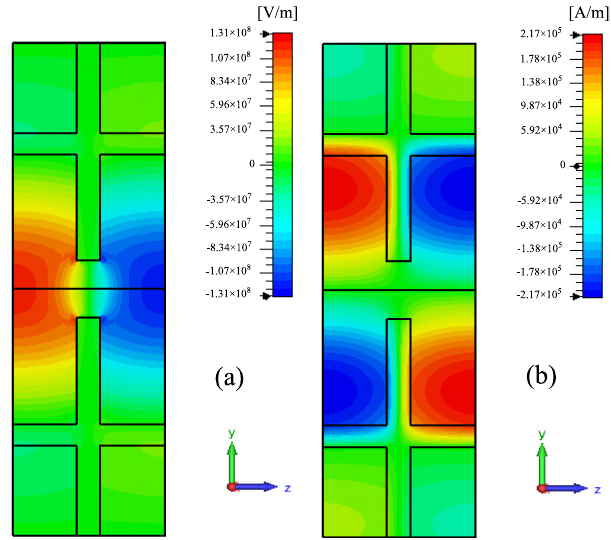
FIG. 4. Contour plots of the field distribution of the accelerating mode in the regular cell. (a) Electric field distribution E z ð r; θ ; z Þ . (b) Magnetic field distribution H θ ð r; θ ; z Þ . These plots of the field intensity are shown in arbitrary